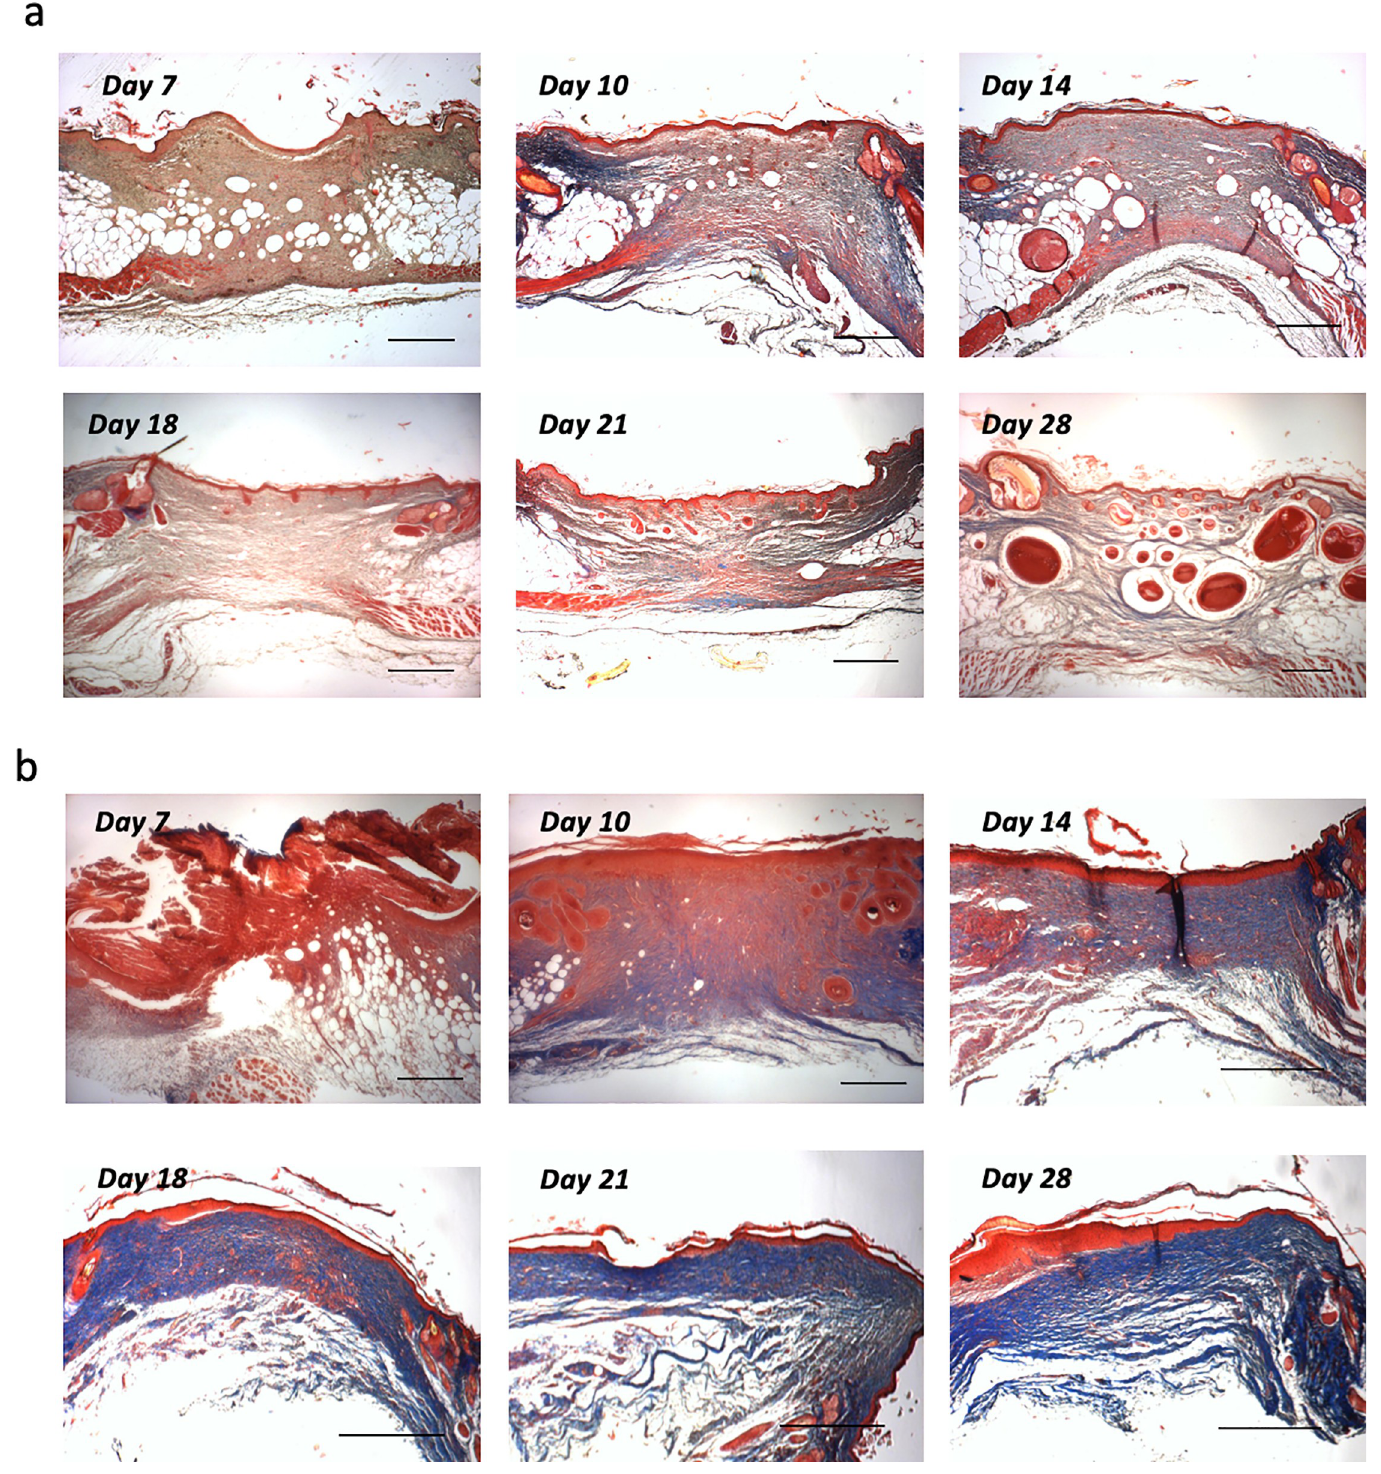
Fig 4. Histological analysis of wound healing reveals de novo regeneration of muscle fibers in A . cahirinus . Masson Trichrome staining was performed for paraffin wax embedded sections for day 7, 10, 14, 18, 21 and 28 wounds for (a) A cahirinus and (b) M . musculus . Scale bars 200 μ m.